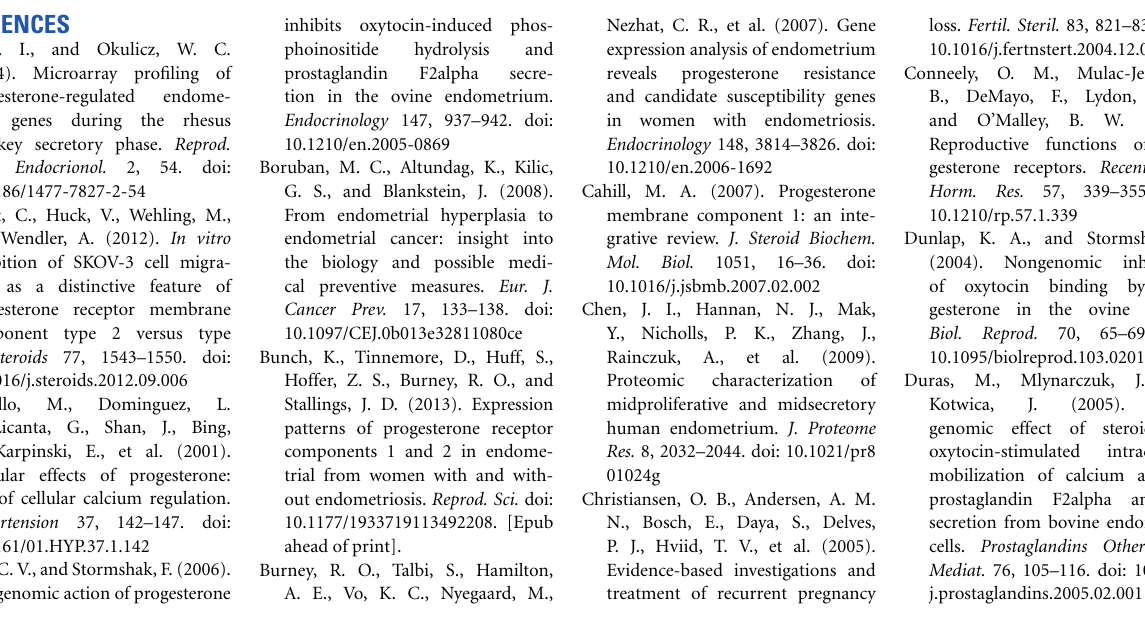
normal glandular tissue in control (D) sections, with development of vacuoles in glandular epithelium in sections from cKO mice (E) . Epithelial cells with pyknotic nuclei consistent with apoptosis, disruption of the transitional zone between epithelial and stromal tissues and infiltration of immune cells are also evident in sections obtained from cKO female mice (F)